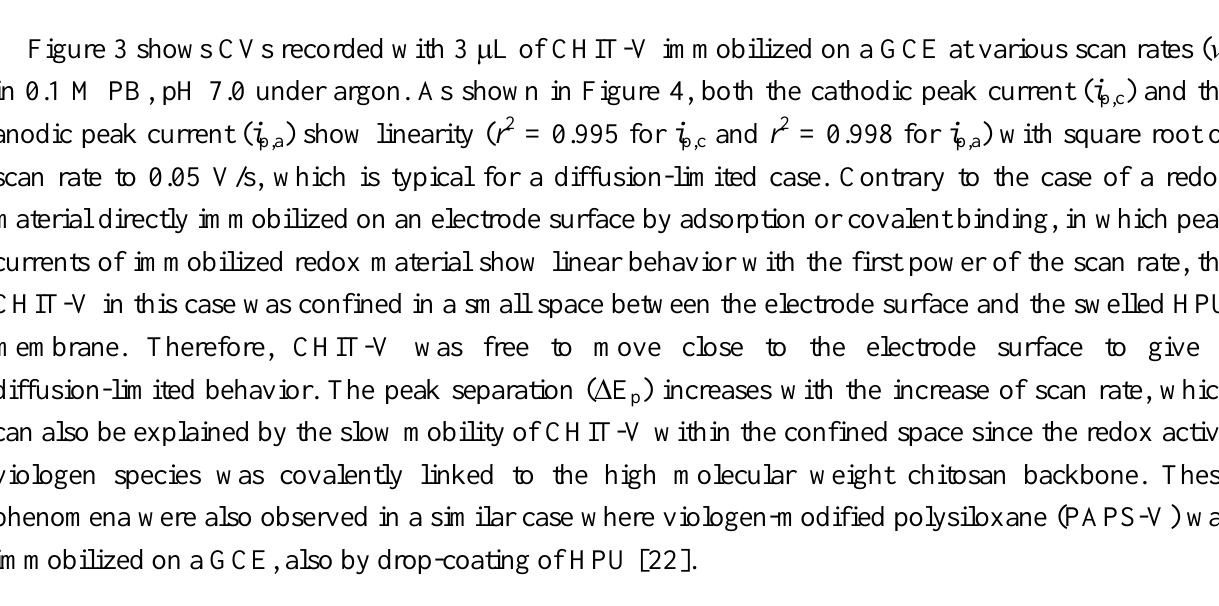
Figure 3. CVs recorded with CHIT-V immobilized GCE in 0.1 M phosphate buffer, pH 7.0 under argon. Scan rates are 0.002, 0.005, 0.01, 0.025 and 0.05 V/s, respectively in the direction of peak current